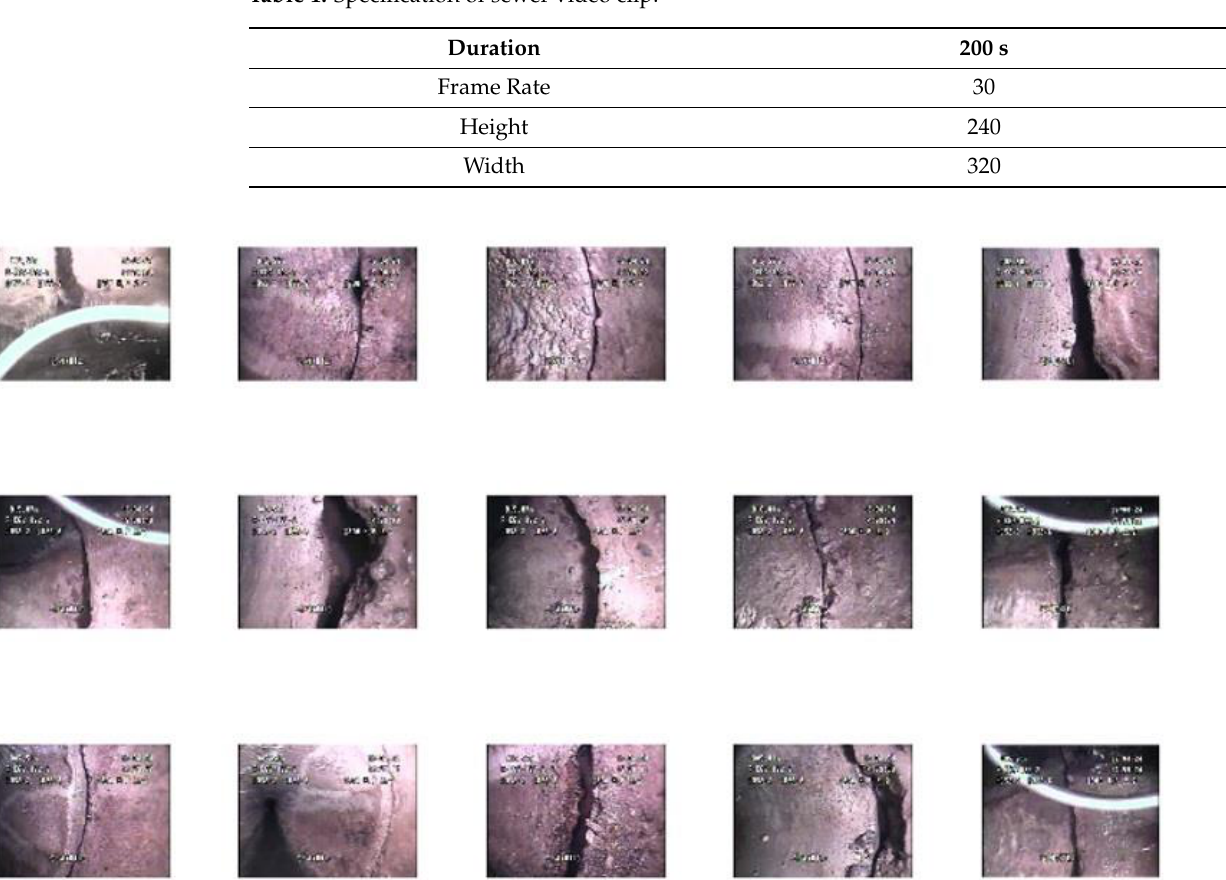
Table 1. Specification of sewer video clip.